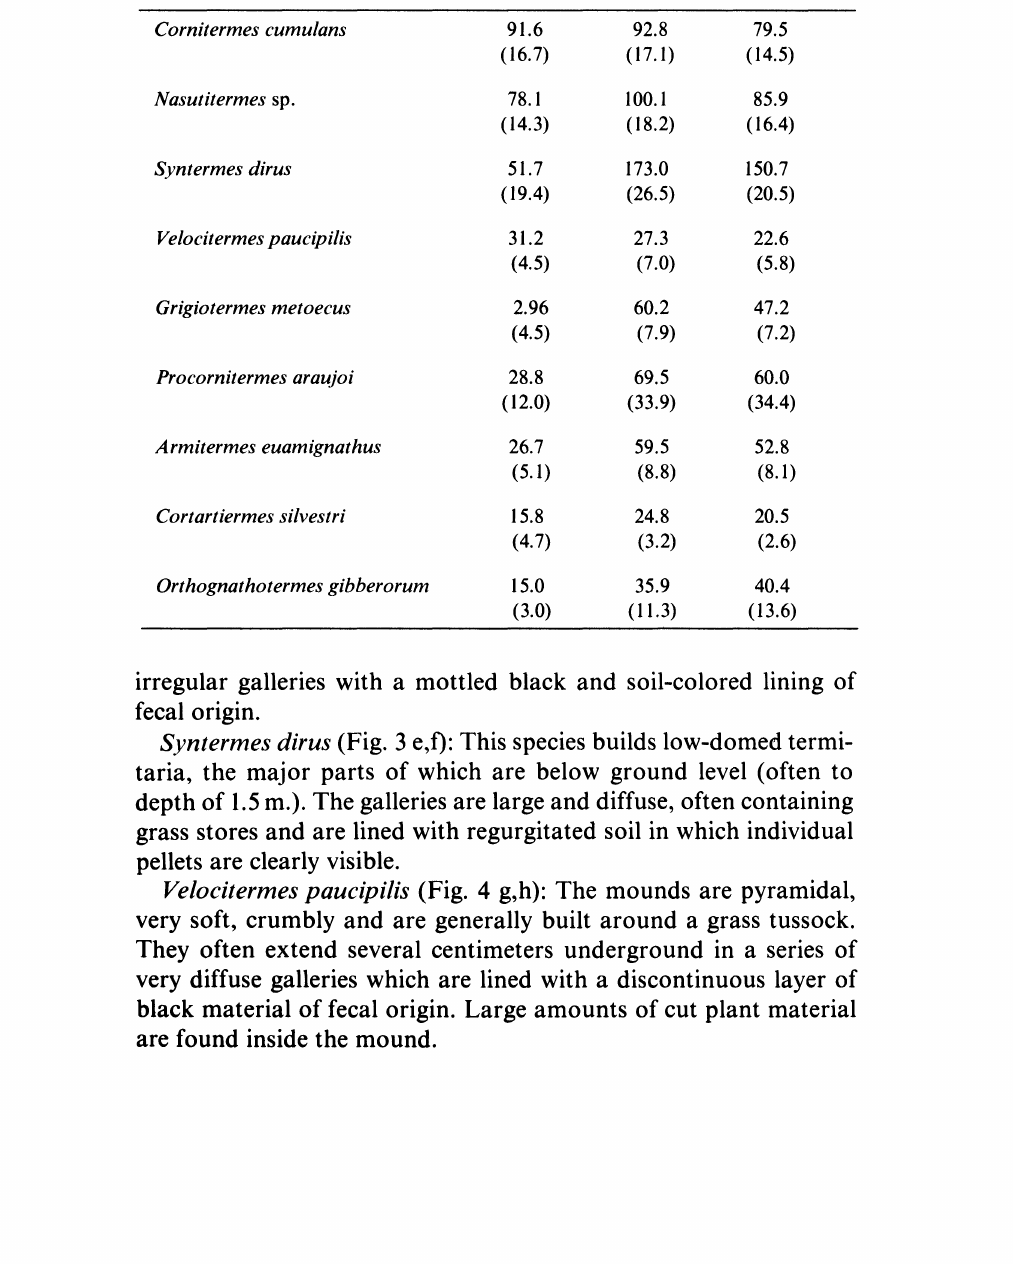
Table 4. Dimensions of the epigeal portion of termite mounds (measurements expressed in centimeters; mean with standard deviation in